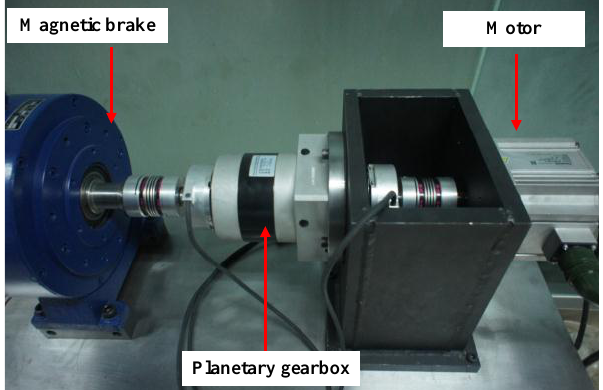
Figure 4. Planetary gearbox test rig.